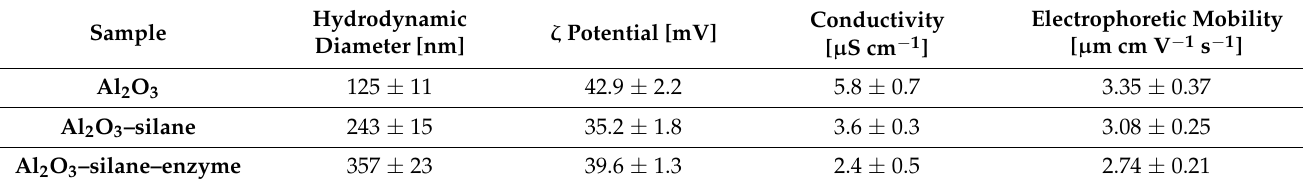
Table 1. DLS and ζ (zeta potential) characteristics of the ceramic materials.